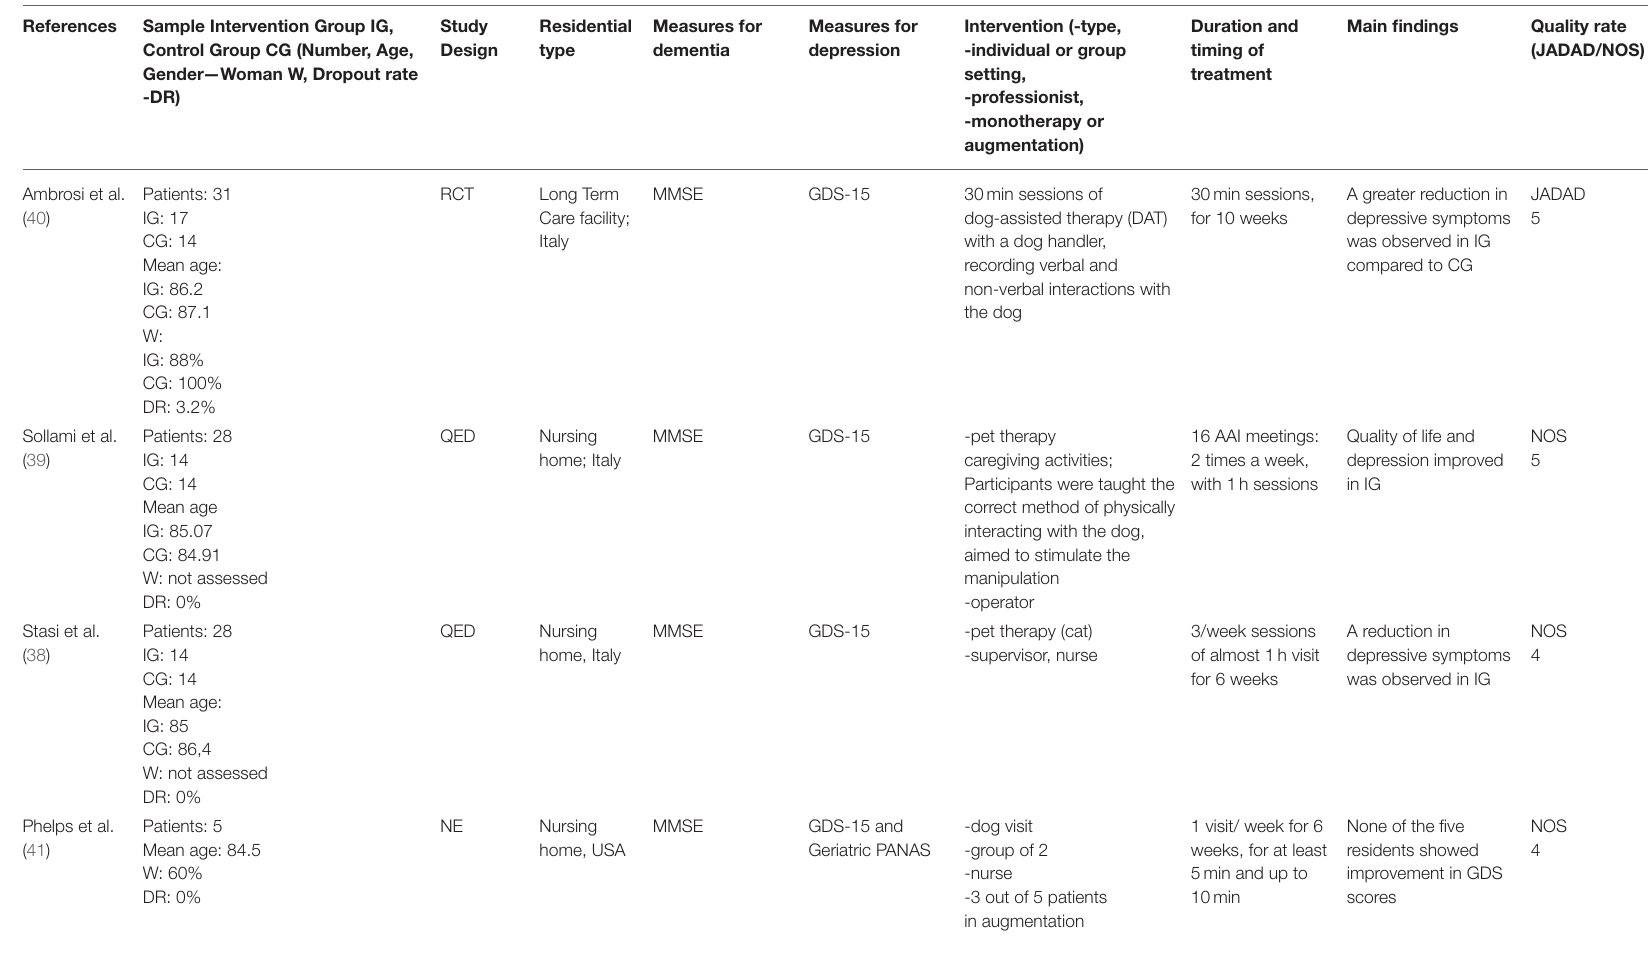
TABLE 2 | Pet therapy studies (n 4 articles). Sample Intervention Group IG, Control Group CG (Number,